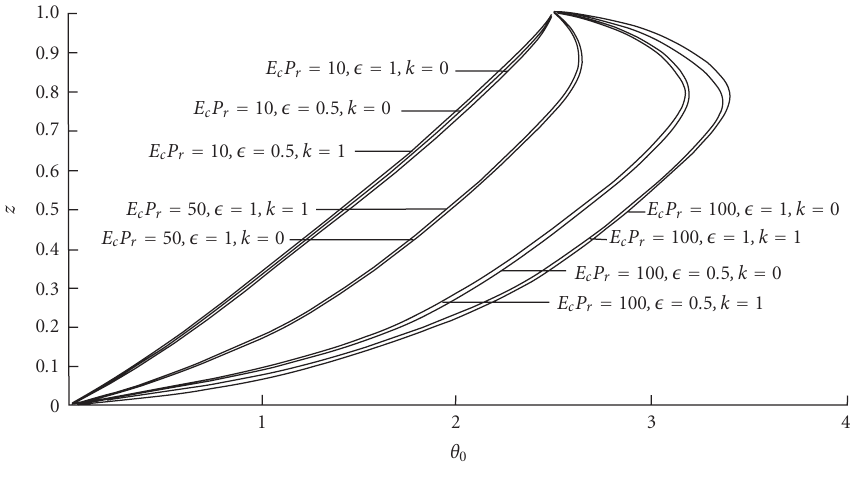
Figure 6.1. Steady temperature profiles in a two-phase